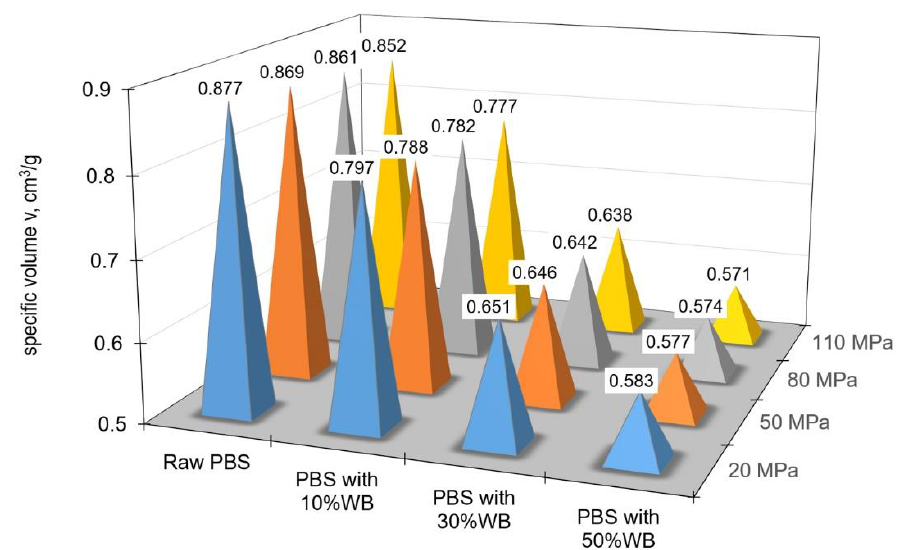
Figure 6. Changes in specific volume depending on pressure and filler content at ambient temperature (35 °C).